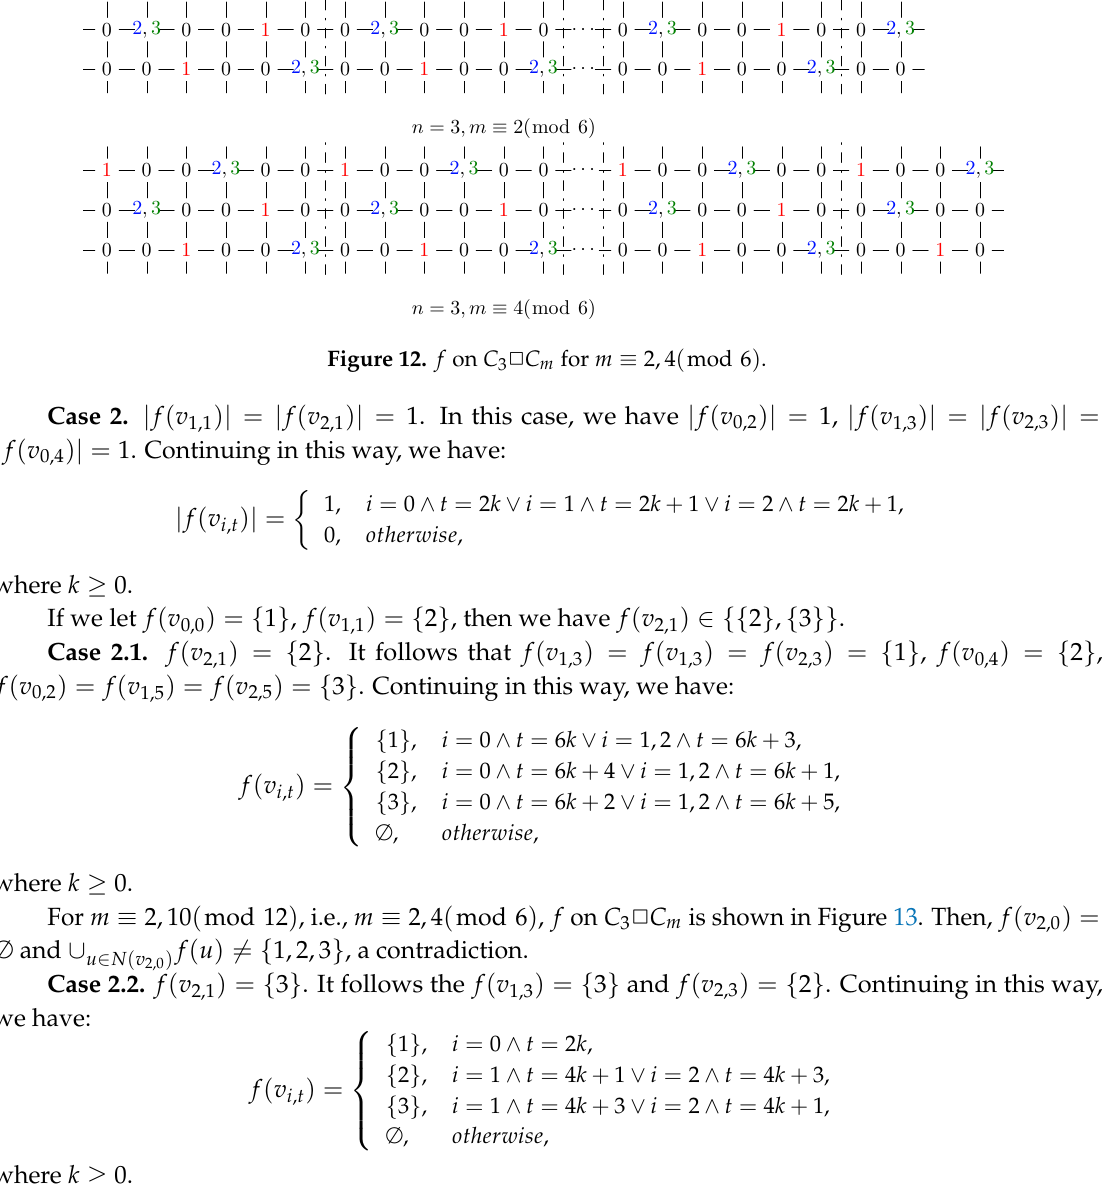
Figure 13. Graph of f in Case 4.2.1